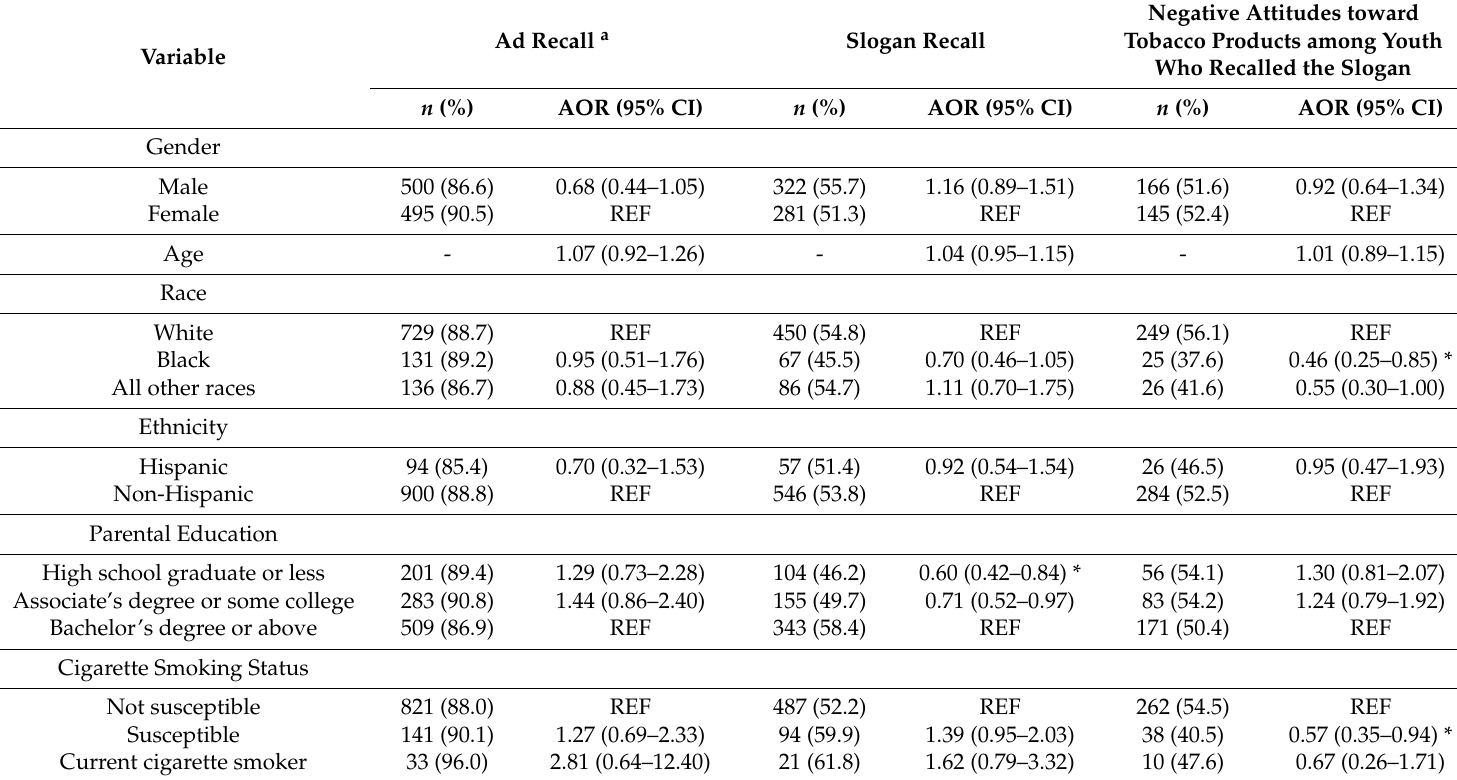
Table 2. Factors associated with ad recall, slogan recall, and negative attitudes toward tobacco